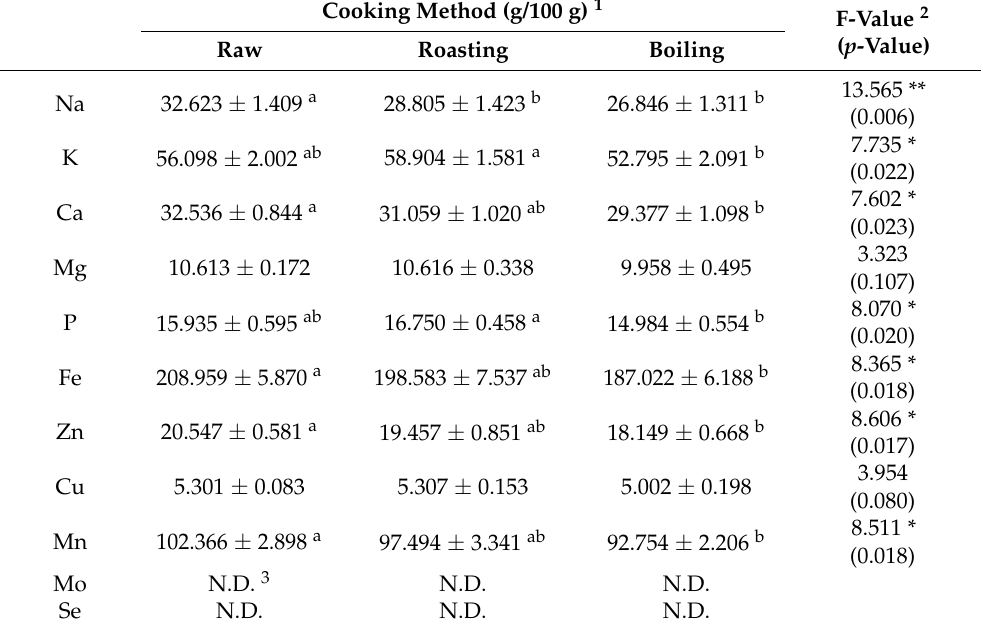
Table 2. Mineral composition of raw, roasted, and boiled Tonka